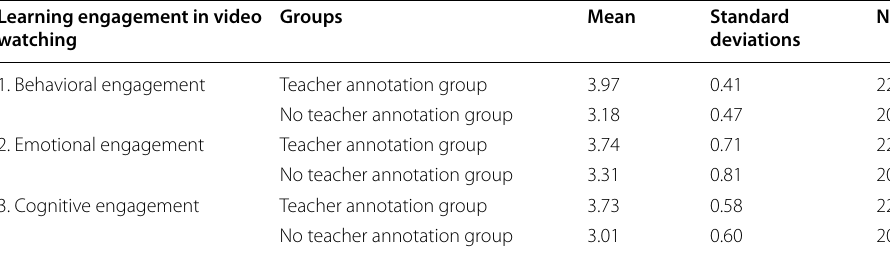
Table 1 Means and standard deviations for learning engagement in video watching Learning engagement in video